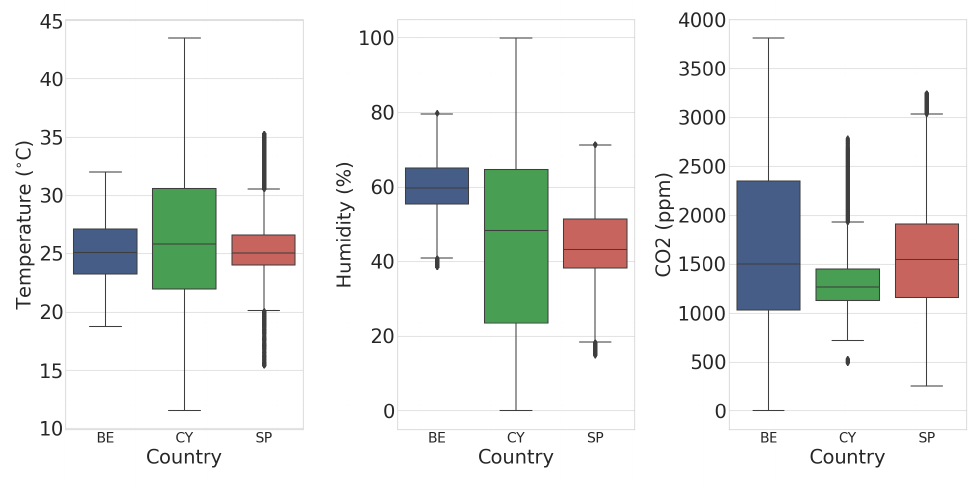
Figure 2. A boxplot describing the temperature, humidity, and CO 2 sensor data for the three countries included in the data collection—Belgium (BE), Cyprus (CY), and Spain (SP)—after preprocessing.